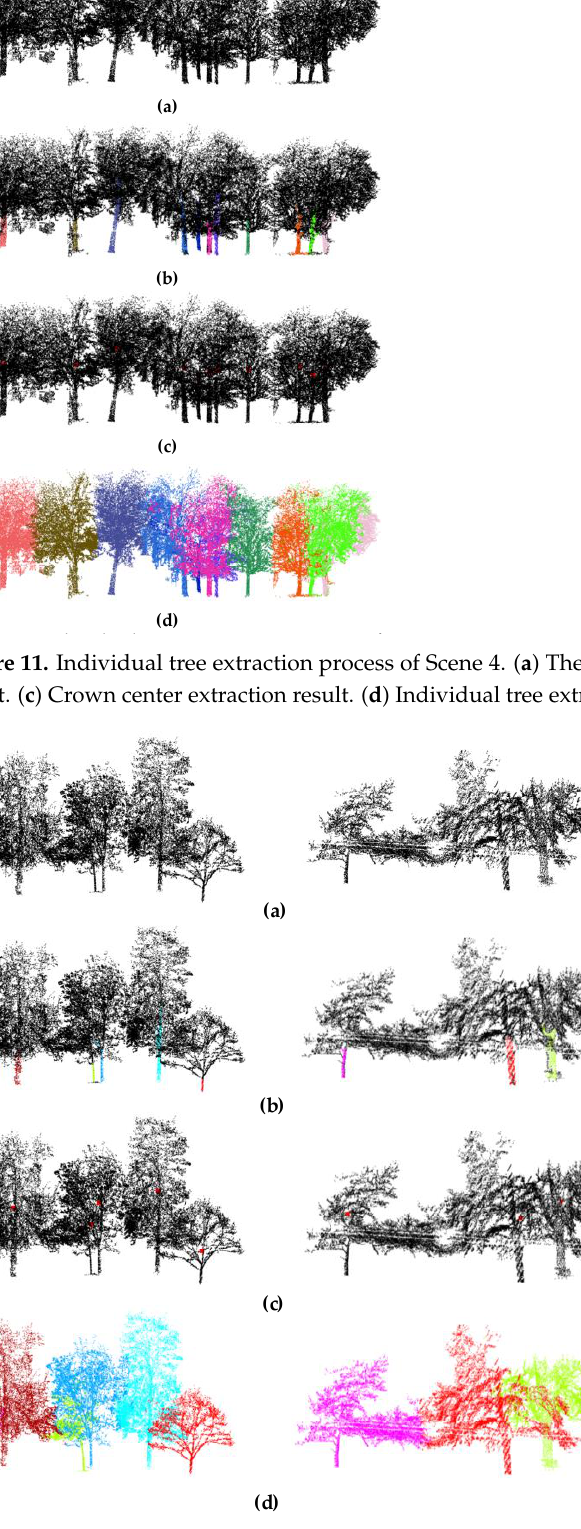
Figure 12. Individual tree extraction process of Scene 5. ( a ) The PCD of trees. ( b ) Trunk extraction result. ( c ) Crown center extraction result. ( d ) Individual tree extraction result.